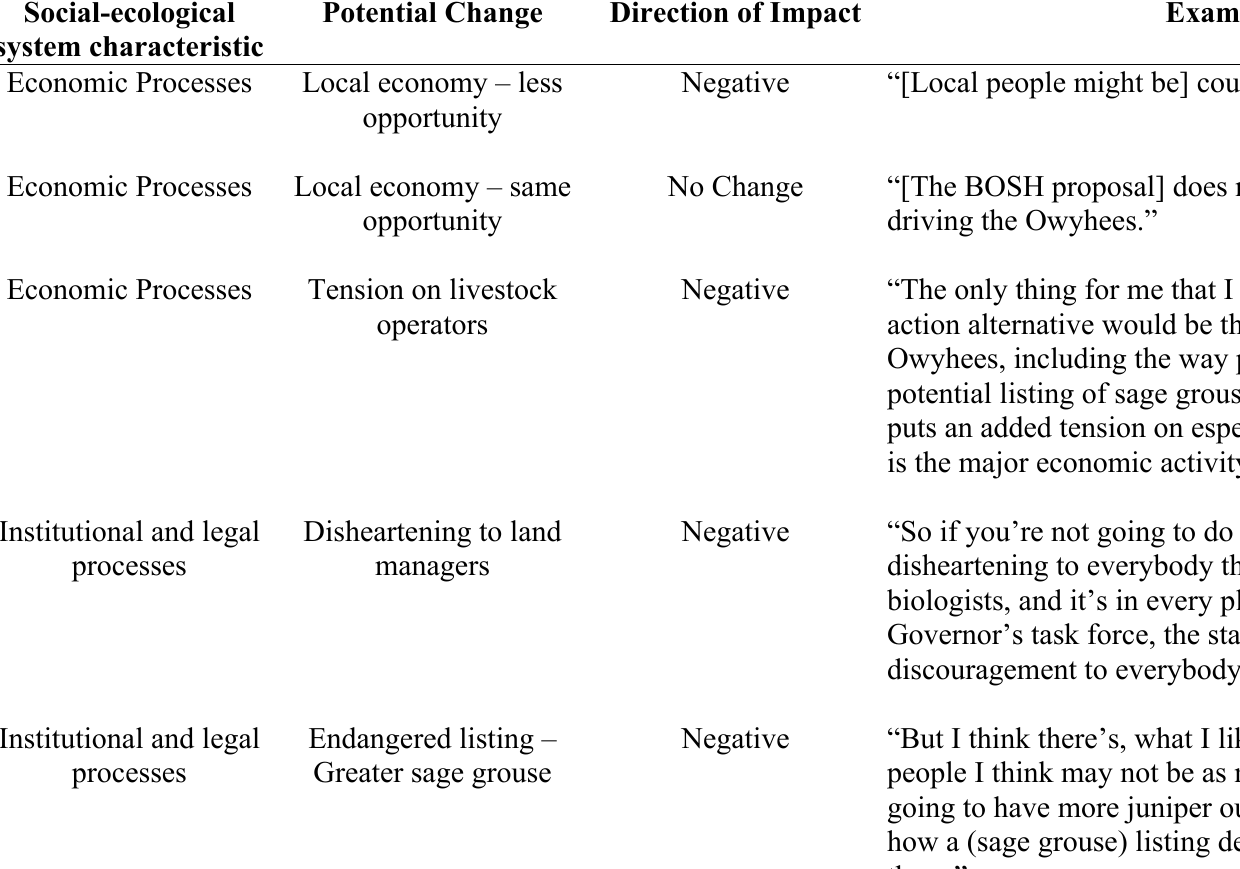
Table 1. Workshop participants' responses to the no action